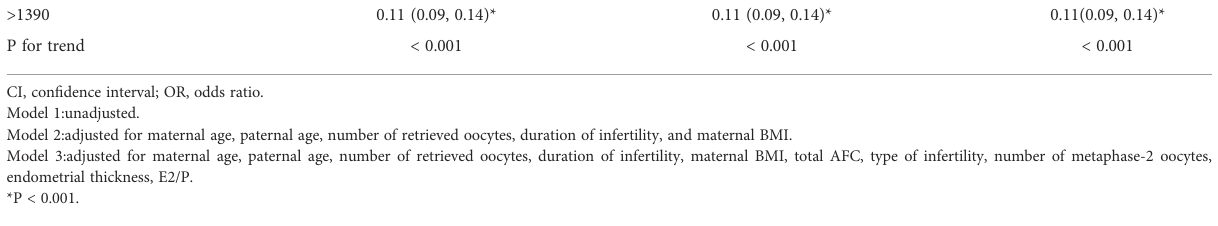
CI, con fi dence interval; OR, odds ratio. Model 1:unadjusted. Model 2:adjusted for maternal age, paternal age, number of retrieved oocytes, duration of infertility, and maternal BMI. Model 3:adjusted for maternal age, paternal age, number of retrieved oocytes, duration of infertility, maternal BMI, total AFC, type of infertility, number of metaphase-2 oocytes, endometrial thickness, E2/P. *P <